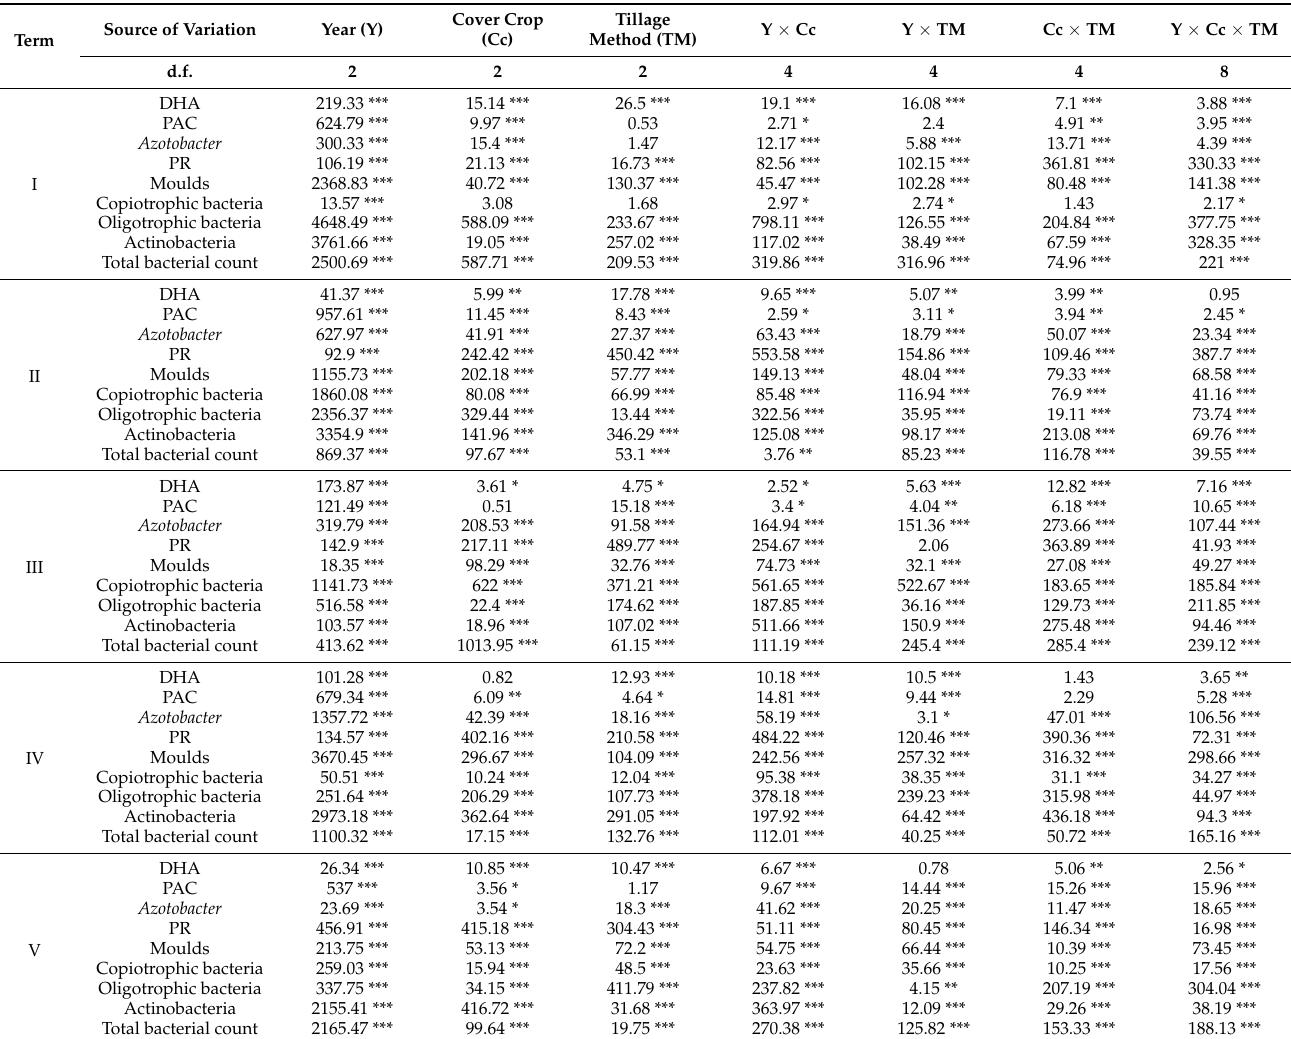
Table 3. F -statistic from three-way analysis of variance for the traits observed at the five terms. Source of Term